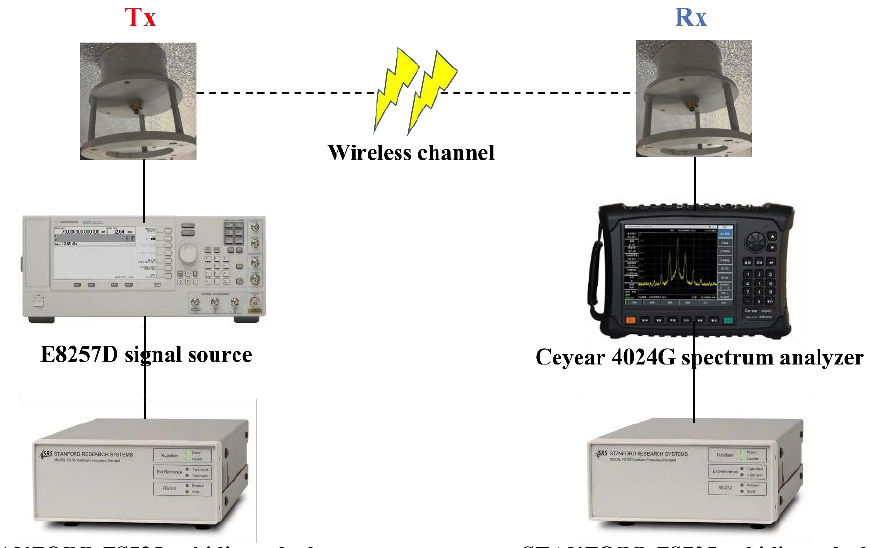
Figure 7. The configuration of the measurement system.